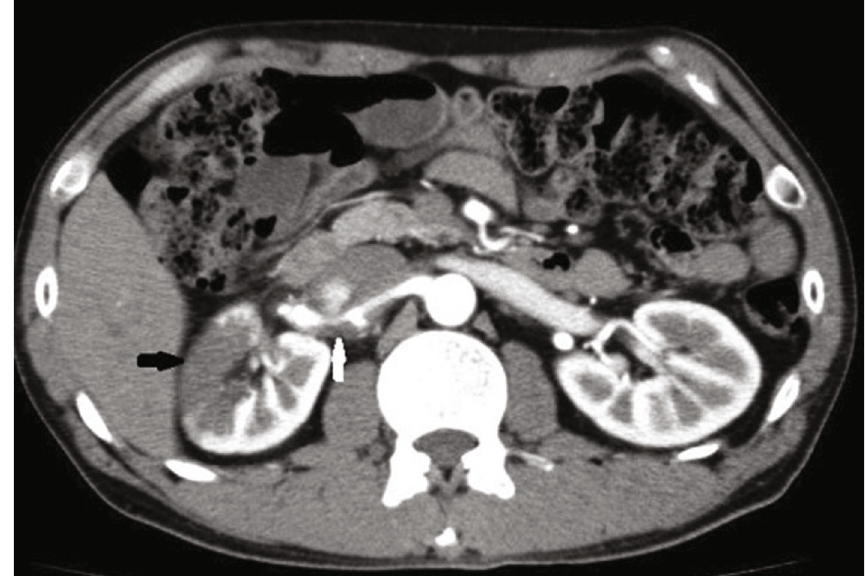
Figure 2: Right renal artery dissection (white arrow) and renal infarction (black